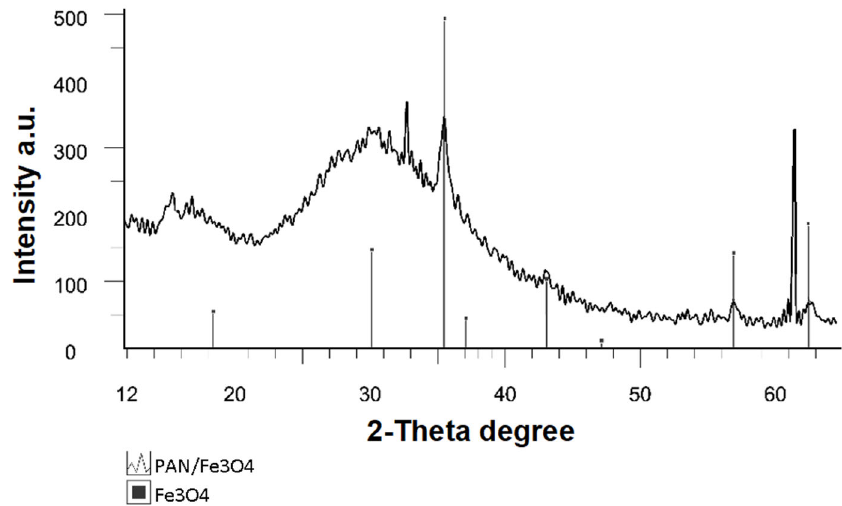
Figure 8. XRD patterns of PAN/Fe 3 O 4 fibers.